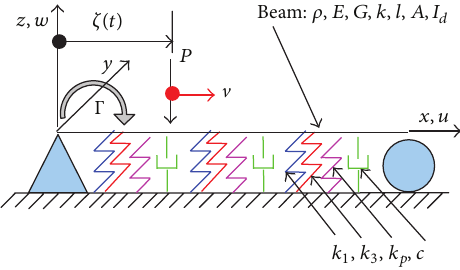
Figure 3: A simply supported Timoshenko beam resting on a nonlinear Pasternak viscoelastic foundation and subjected to a moving force 𝑃 (see [17]).